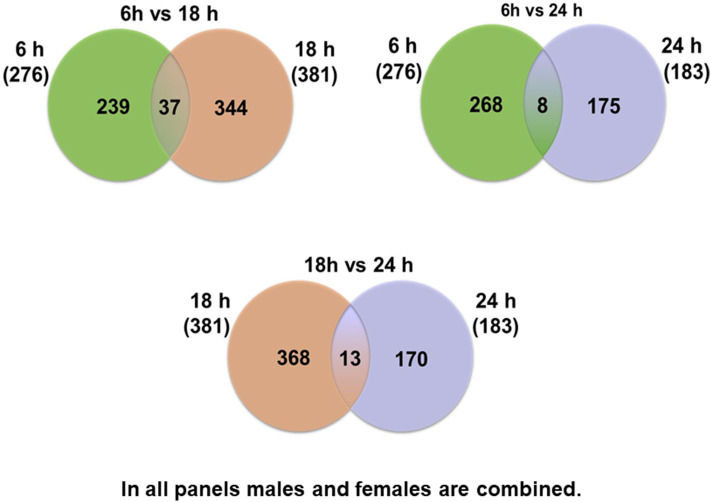
Comparison of the number of genes affected by K. pneumoniae in males and females at different time points. The Venn diagrams show genes identified in common after comparison of two different time points. Thirty-seven genes were in common between 6 vs. 18 h, and 239 were unique for the 6 h time point and 344 were unique for the 18 h time point. Eight genes were identified in common between 6 vs. 24 h, and 268 were unique for the 6 h time point and 175 were unique for the 24 h time point. The comparisons between 18 vs. 24 h revealed 13 genes in common in both groups and 368 unique for the 18 h and 170 unique for the 24 h time point.